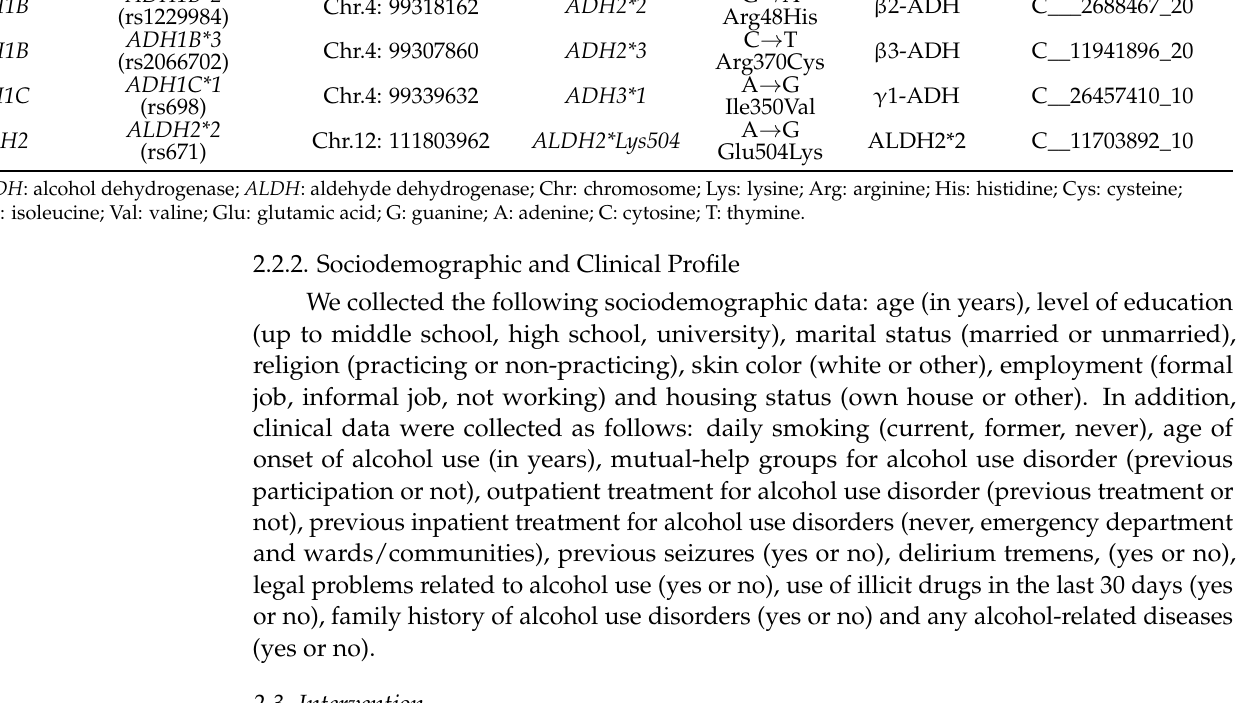
Table 1. Description of the polymorphisms and their corresponding genes, including genomic coordinate, other names, amino acid change (for missense alterations), protein subunit encoded and TaqMan ® assays code.